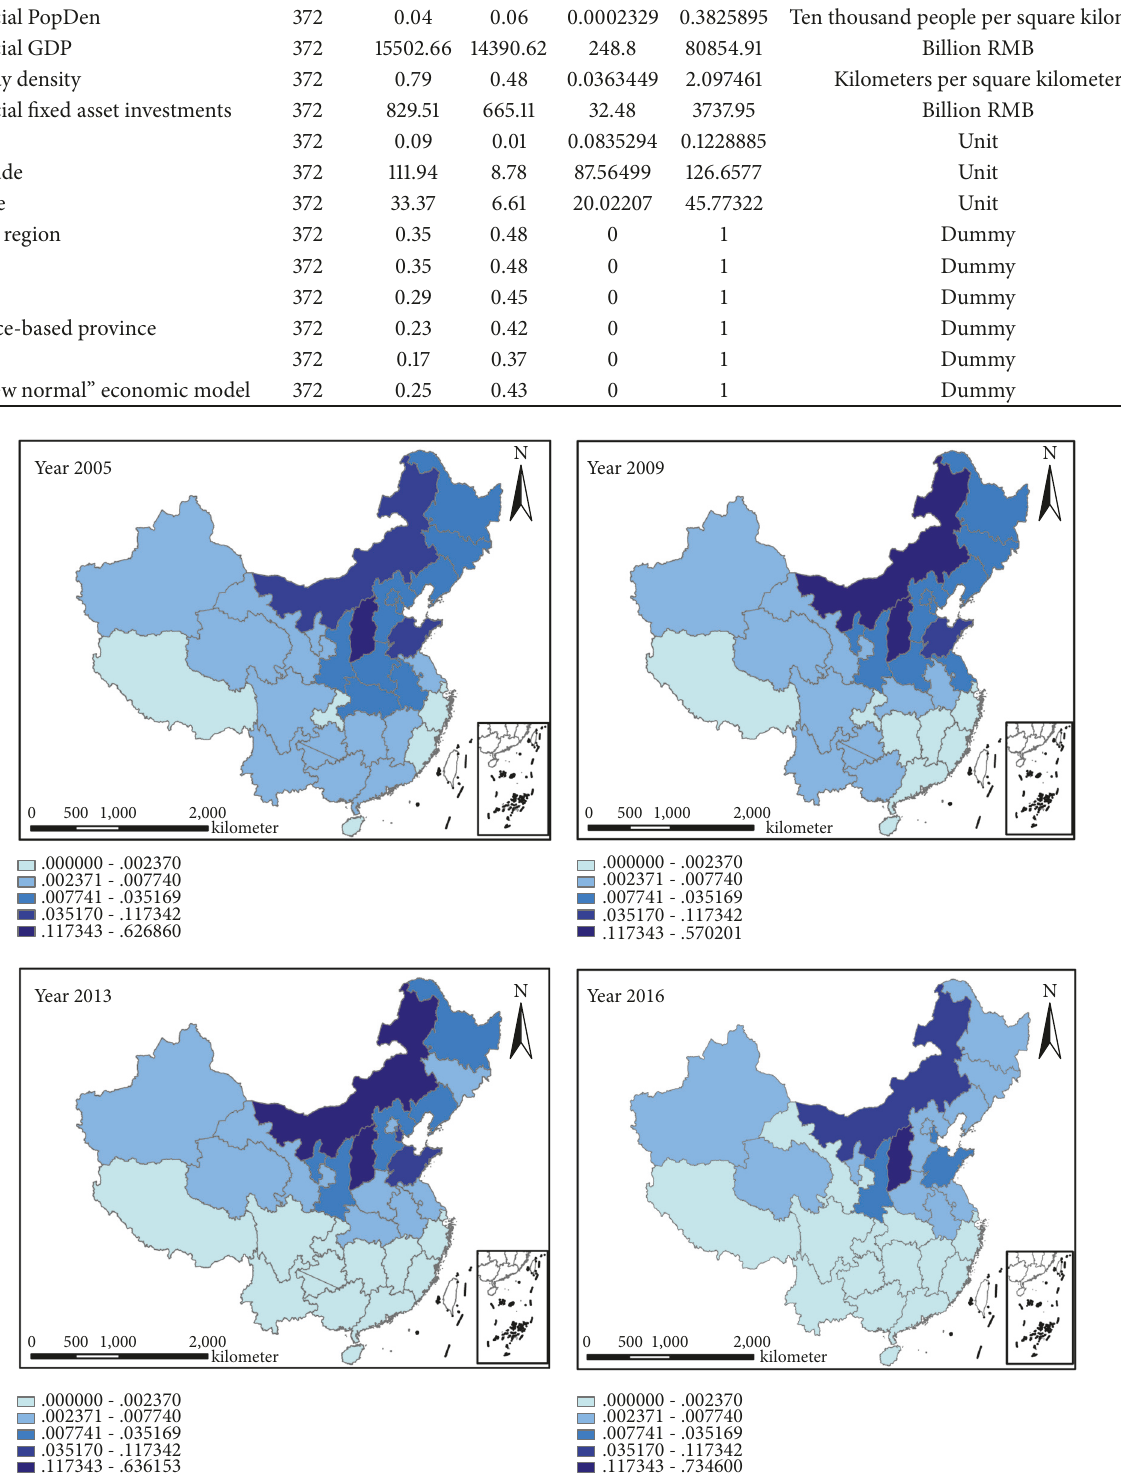
Figure 2: The evolution of Hub from 2005 to